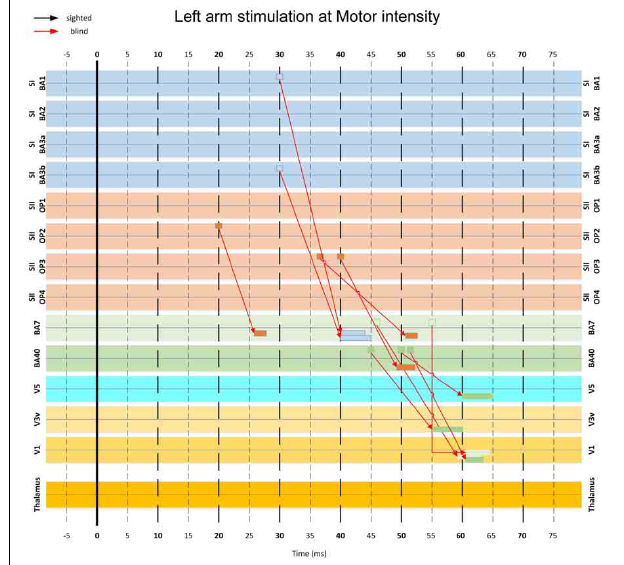
FIGURE 11 | A more detailed version of part of the diagram in Figure 10, showing the key connections involved in the pathway from the somatosensory to the visual cortex via posterior parietal areas. Note that some connections appearing in this figure have been omitted in Figure 10 for